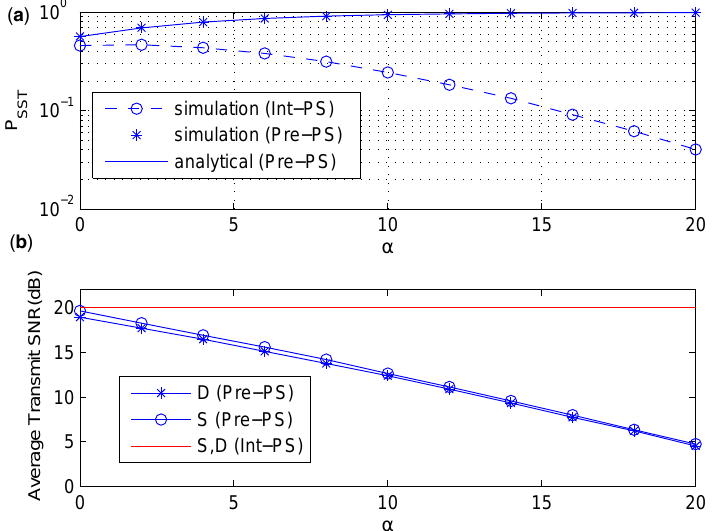
Figure 6. ( a ) P SST under various α . ( b ) The average transmit SNR under various α